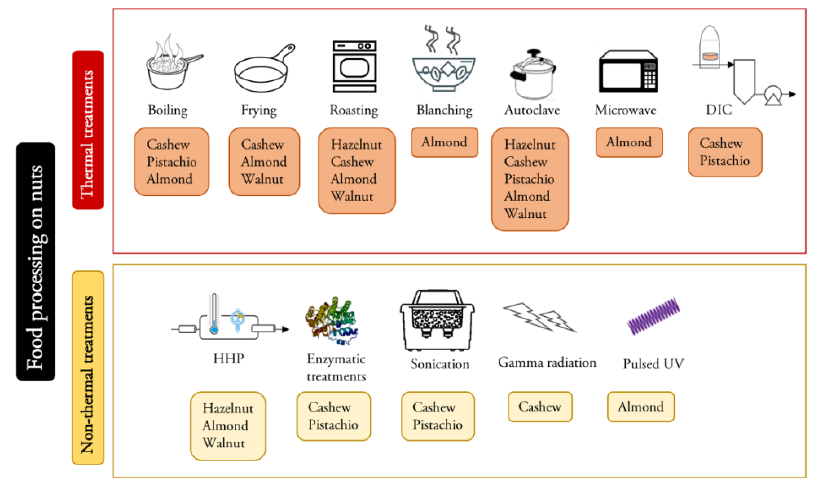
Figure 1. Summary of food processing methods and their applications in the reviewed nuts. Table 2. Effects of processing on IgE immunoreactivity of nut allergens.